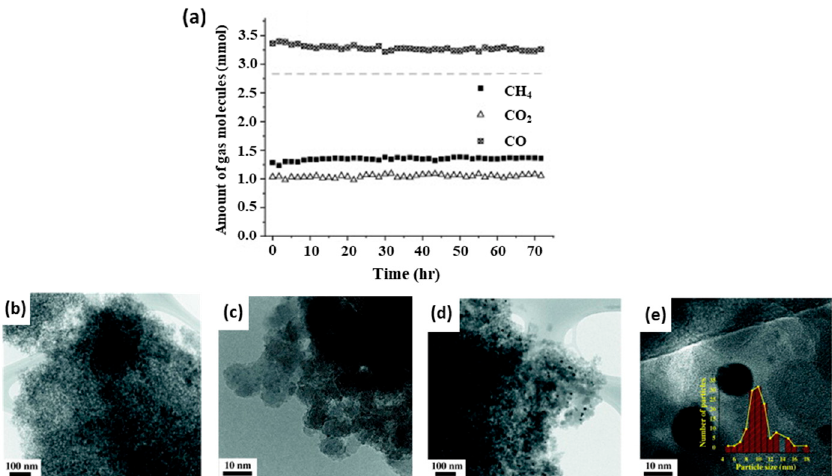
Figure 15. ( a ) Amount of gas molecules as a function of time in the effluent of a reactor containing a 50Ni/m-SiO 2 ALD catalyst subjected to DRM at 800 °C. Reaction conditions: T = 800 °C, P = 1 atm, CH 4 /CO 2 = 1/1 ( V / V ), total flow rate = 20 mL min − 1 , m cat = 100 mg. ( b ) TEM image of 50Ni/m-SiO 2 before DRM and ( c ) corresponding high magnification TEM image. ( d ) TEM image of 50Ni/m-SiO 2 after DRM and ( e ) corresponding high magnification TEM image. The inset in ( e ) is the Ni NP size distribution of the sample in ( d ). Reprinted with permission from Ref. [243]. Copyright 2013 Elsevier.